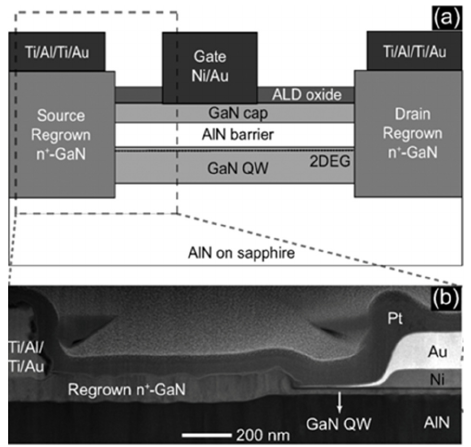
Figure 15. ( a ) Device structures of GaN HEMT with regrown ohmic layer. ( b ) STEM image showing regrown GaN connected to the GaN QW channel [85] . Figure reproduced with permission from IEEE Electron Device Lett.